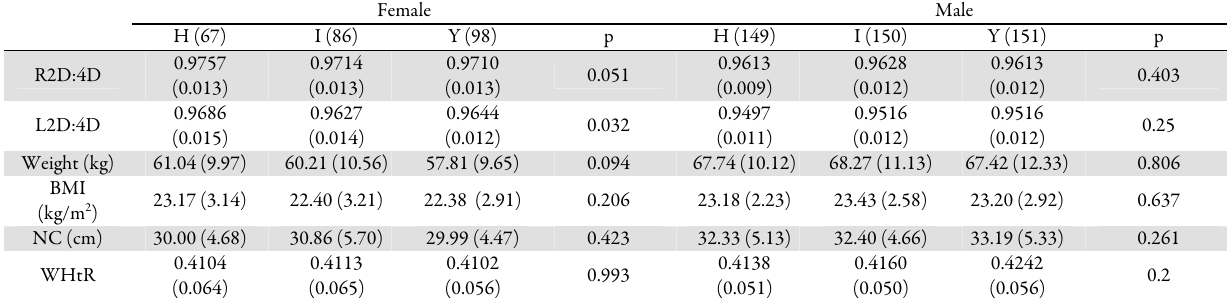
Table 4. Differences in anthropometrics stratified by